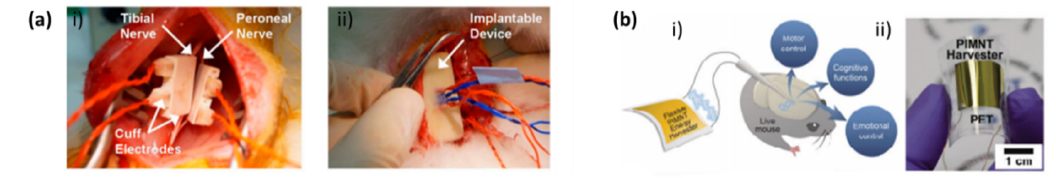
Figure 6. Power supply strategies for implantable biosensors. ( a ) Sensor implantation: (i) cuff electrodes wrapped around the tibial and peroneal nerves and (ii) implantable device inserted under the back skin of a rabbit [107]; ( b ) Deep brain stimulation (DBS) applications using the flexible indium modified crystalline Pb(In1/2Nb1/2)O3-Pb(Mg1/3Nb2/3)O3-PbTiO3 (PIMNT) energy harvester and characteristics of the flexible PIMNT film (i) a schematic illustration of DBS applications using the flexible PIMNT thin film energy harvester and (ii) a photograph of the final flexible PIMNT harvesting device completely bent by human fingers [109].